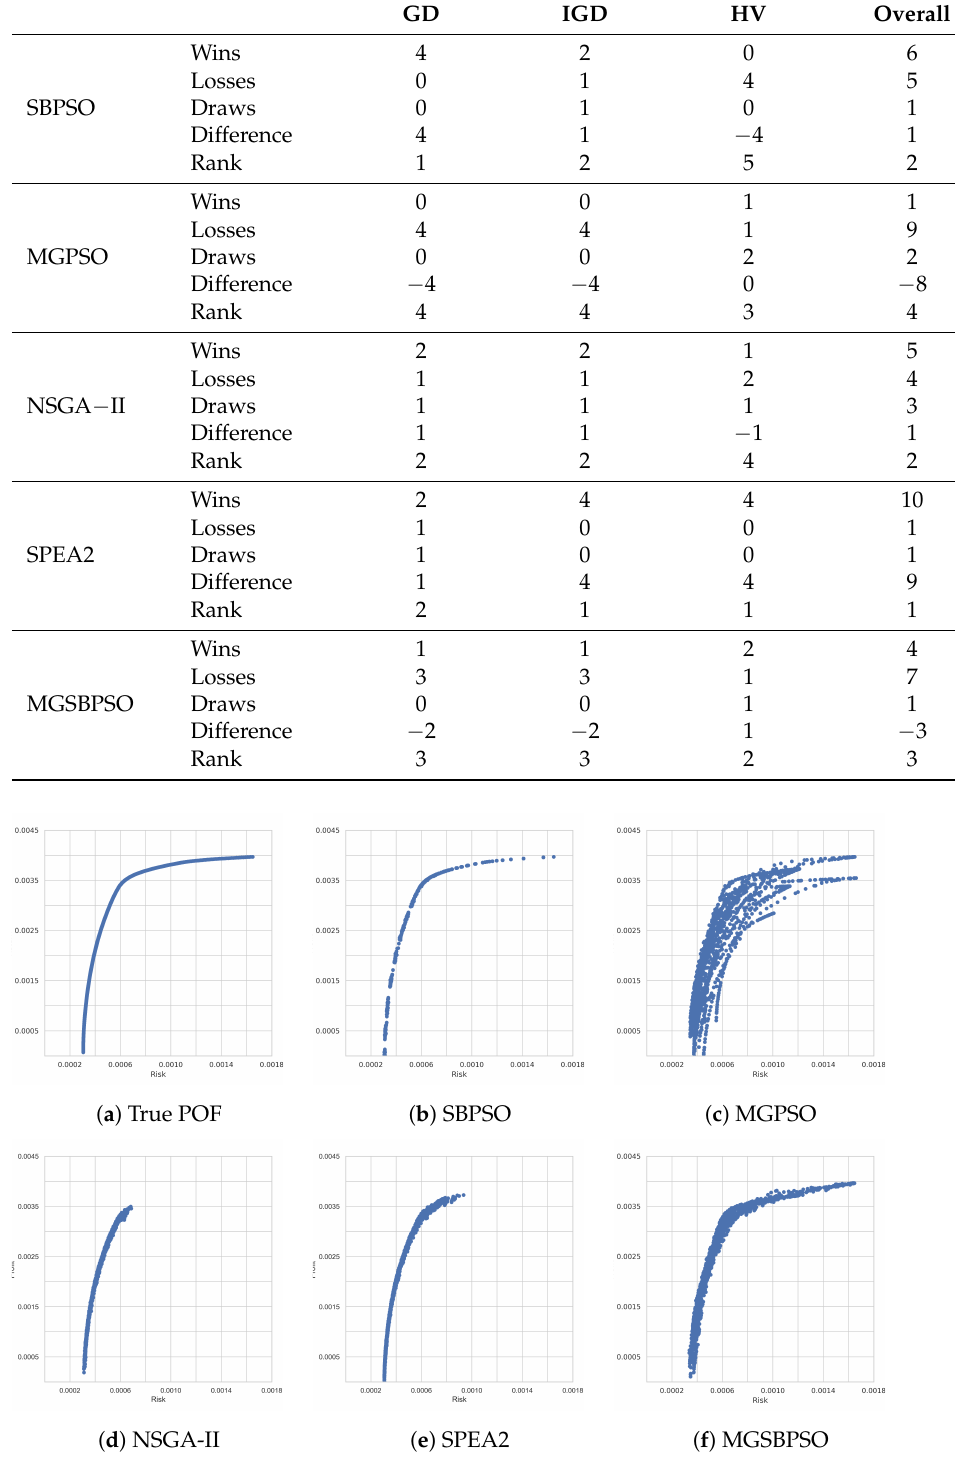
Figure 7. Pareto-optimal obtained fronts for Nikkei